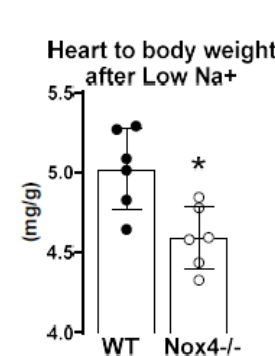
Figure 2. Experimental setup and cardiovascular parameters. A : experimental design. B : systolic blood pressure. C : diastolic. D : heart rate. E : ratio of systolic blood pressure to heart rate. F : ratio of heart to body weight. * p < 0.05, non-parametric test, Mann–Whitney. n ≥ 6.